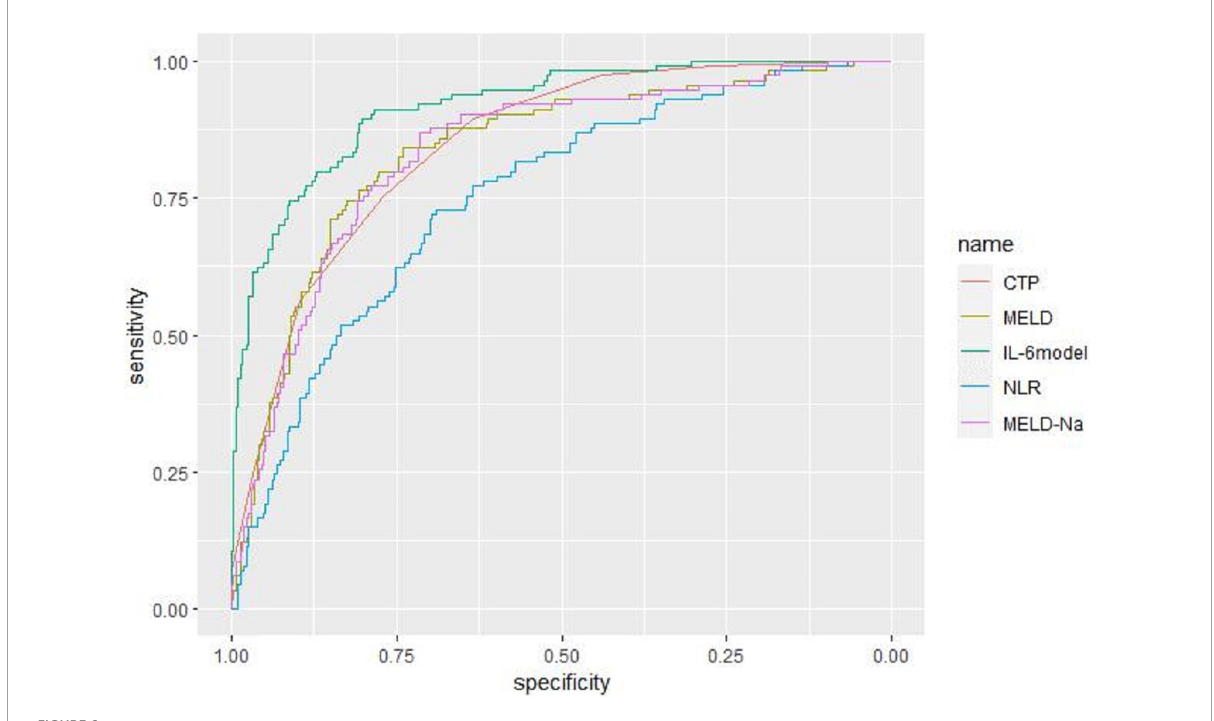
FIGURE6 The ROC curves and comparisons of prognostic scores for 90-day.